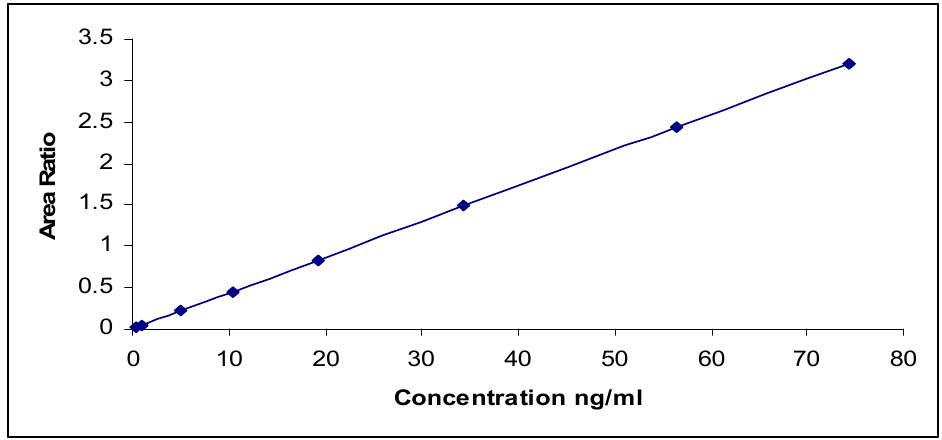
Figure 5. Calibration curve for the mean area ratio of estragole concentration (ranging from 0.50 to 75.0 ng/mL).